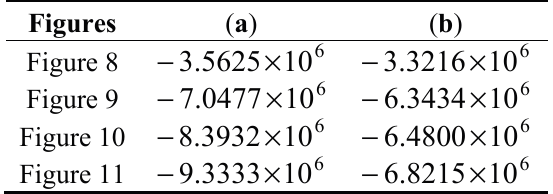
Table 2. Entropies of radar images in Figures